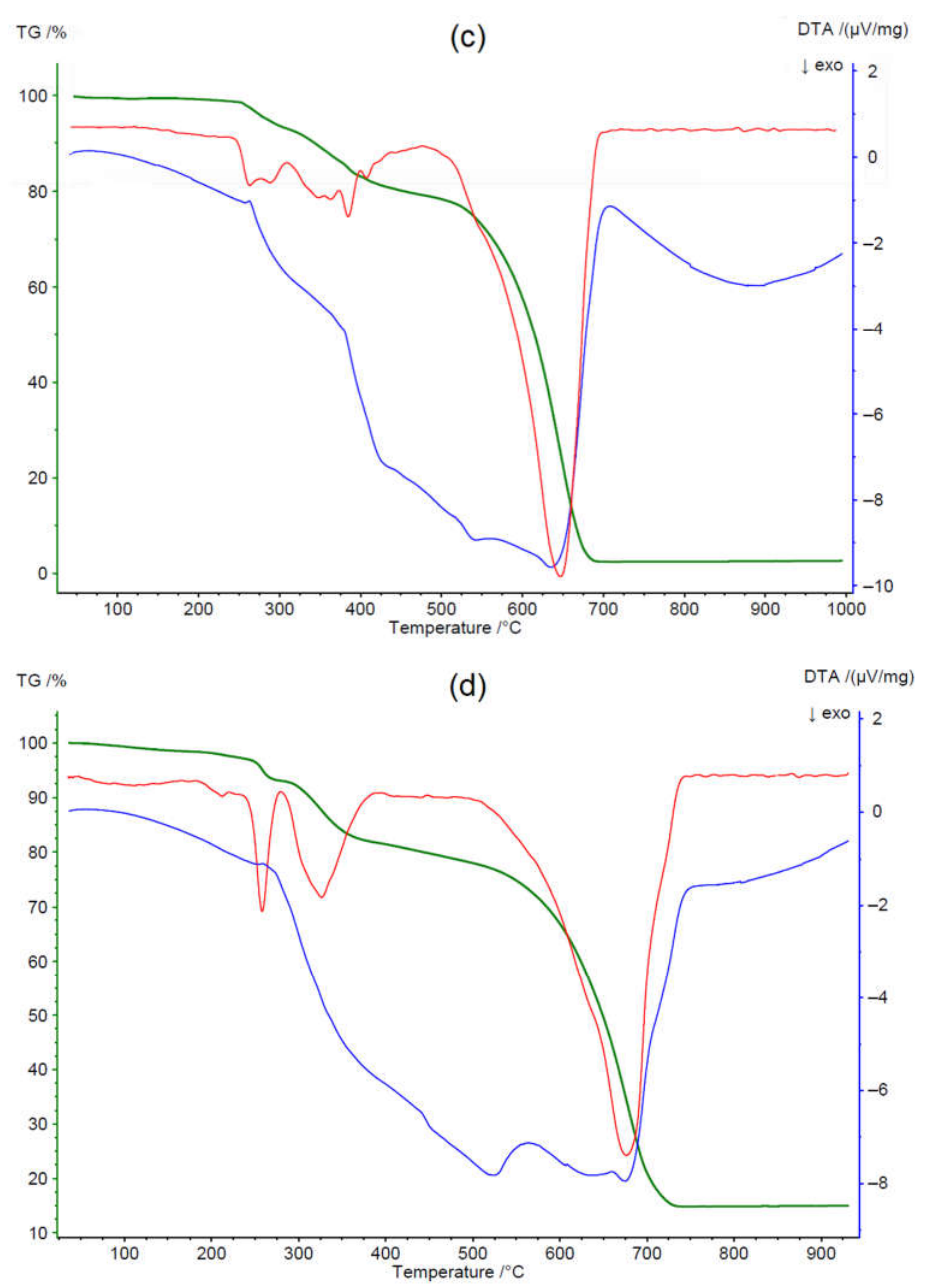
Figure 3. TG (green), DTA (blue), and DTG (red) curves for copper (II) complexes C1 ( a ), C2 ( b ), C3 ( c ), and C4 ( d ).